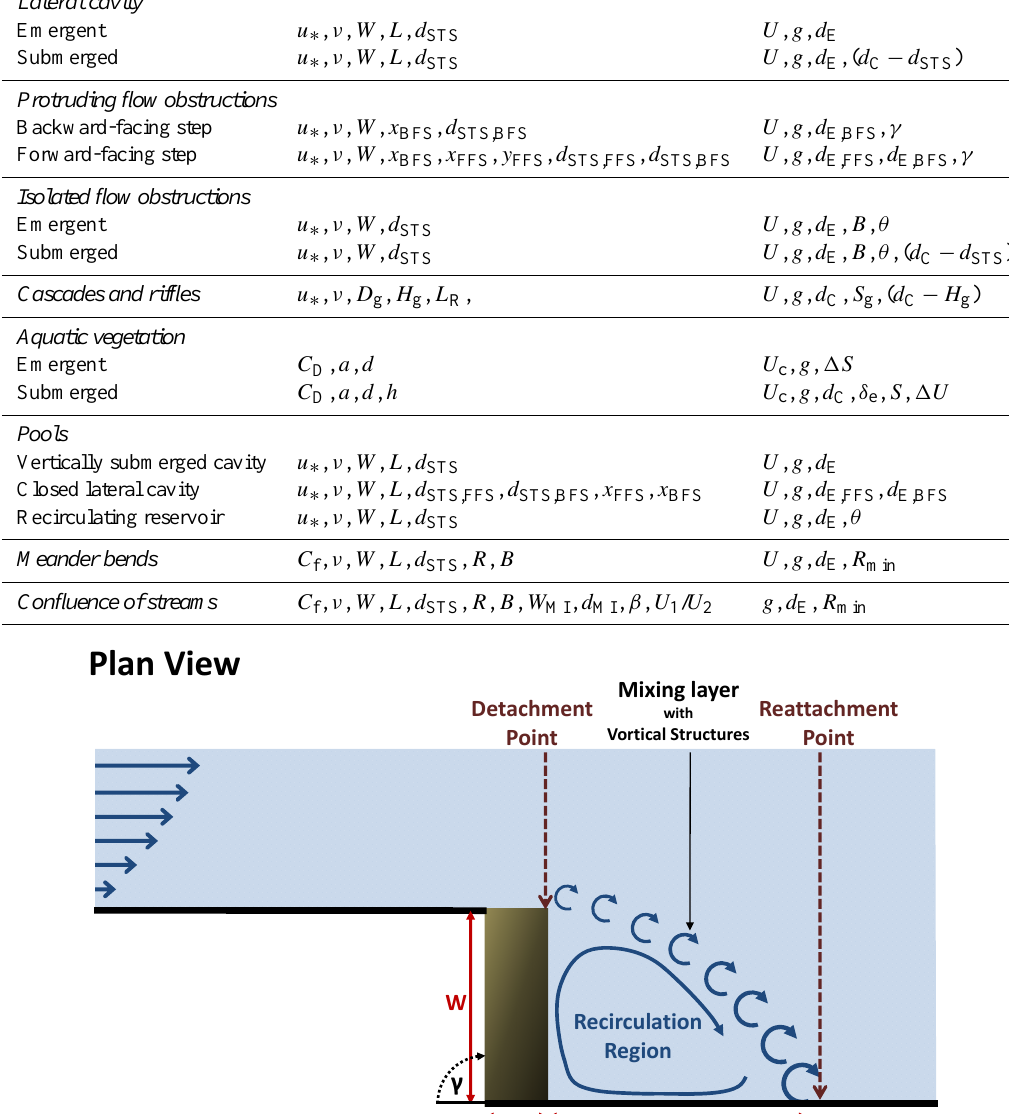
Mean residence time